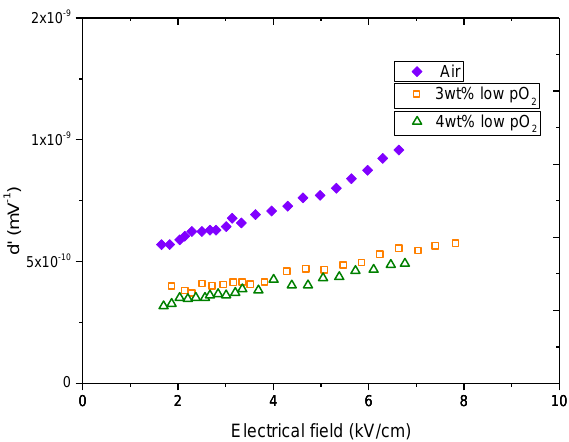
Figure 4. Real piezoelectric coefficients of the sintered PZT-SKN, redrawn from [38].